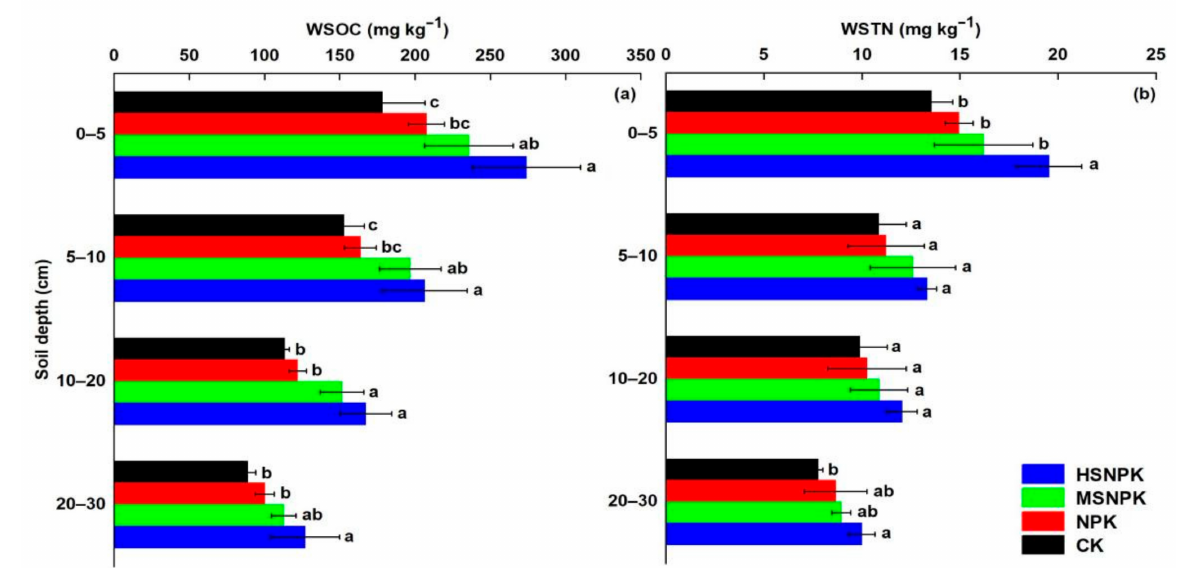
Figure 5. Changes in ( a ) soil WSOC and ( b ) WSTN content at different soil layers under different treatments. The values are means ± SD ( n = 3). Different letters mean statistically significant differences at the 0.05 level. CK: unfertilized control; NPK: mineral NPK fertilizer; MSNPK: moderate wheat straw incorporation (3 t ha − 1 ) plus NPK; HSNPK: high wheat straw incorporation (6 t ha − 1 ) plus NPK. WSOC: water-soluble organic C; WSTN: total water-soluble